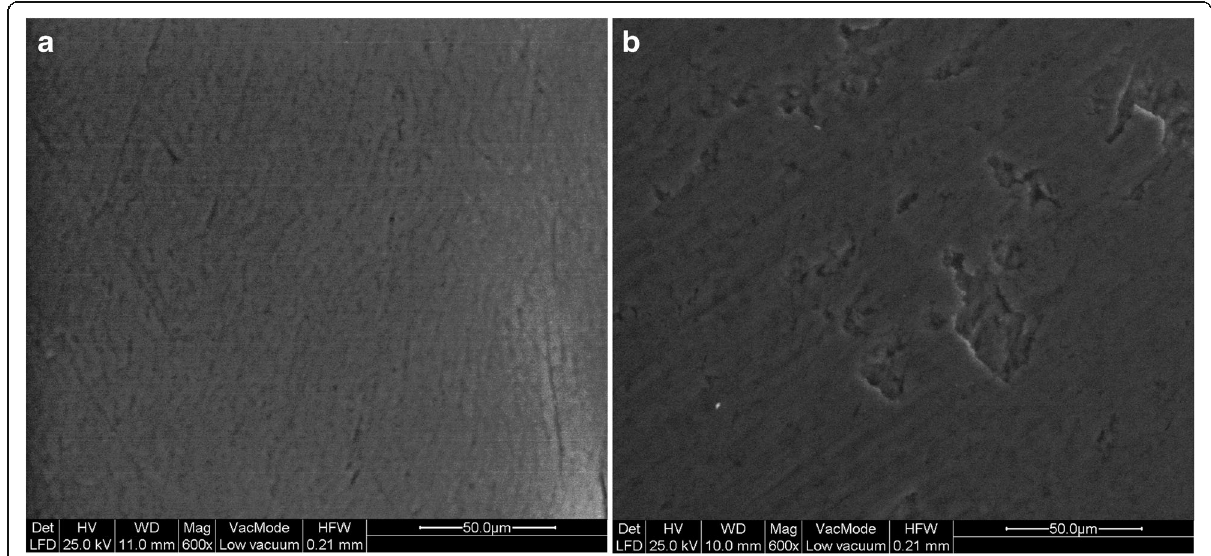
Fig. 3 Representative secondary electron images from the surfaces of intact ( a ) and treated ( b ) enamel. A random distribution of shallow grooves is shown along with a few parallel lines (Original magnification ×